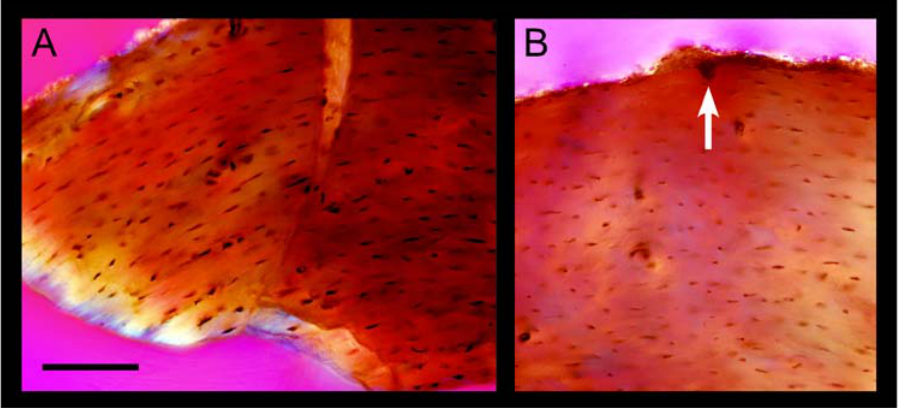
Figure 7. Histological section of an Archaeopteryx femur (BSPG 1999 I 50) viewed with polarized microscopy. (A) Parallel-fibered bone is found throughout the cortex as shown by the flattened, circumferentially oriented, lenticular osteocyte lacunae (tiny black structures) and matted bone fabric (lower left). (B) Primary longitudinal vascular canals are few (large black circular structures). These are occasionally found incompletely formed at the periosteal surface (arrow) and are responsible for the fibrous surface texture of the elements and long striae seen deep within the bones of all known individuals. Scale bar =0.75 mm.